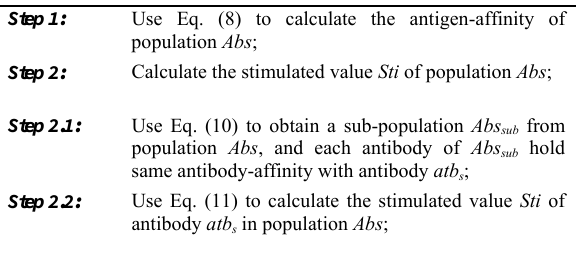
Algorithm 1. The immune selection algorithm